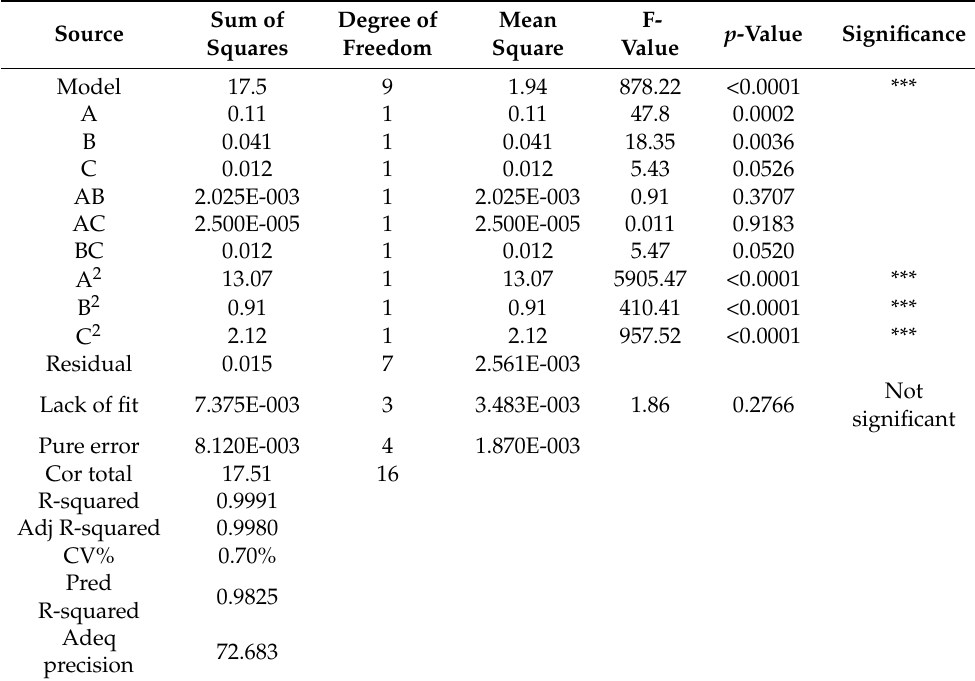
Table 3. Analysis of variance (ANOVA) of the quadratic model and lack of fit. Sum of Degree Source Squares